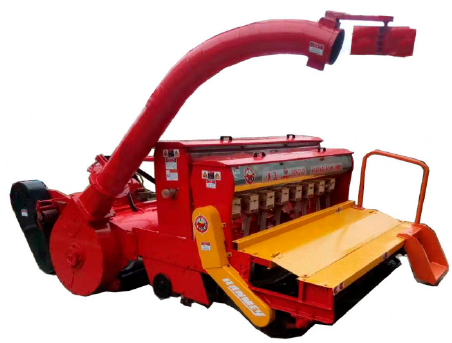
Figure 15. Rice straw crushing and scattering sowing system.